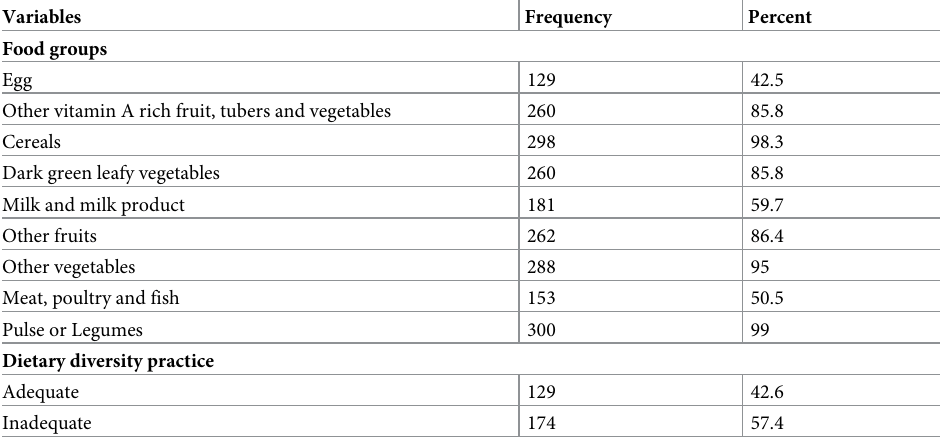
Table 3. Consumption of food groups and dietary diversity practice among study participants in Wachemo Uni- versity Nigist Eleni Mohammed Memorial referral hospital,